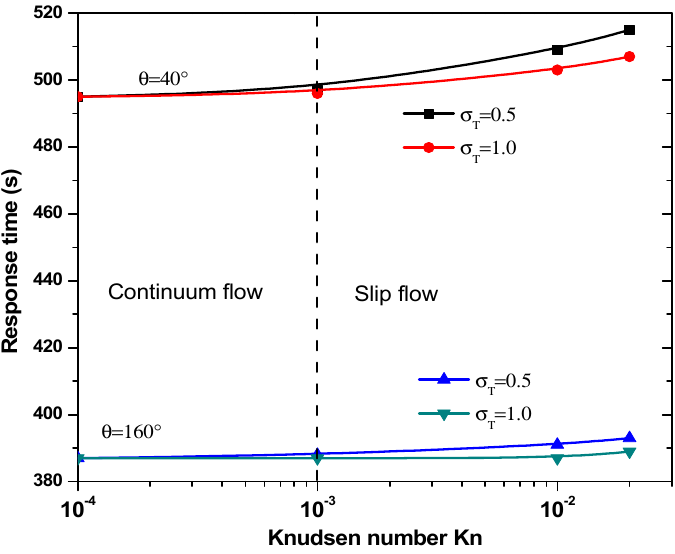
Figure 9. Response time versus the Knudsen number for first structure.